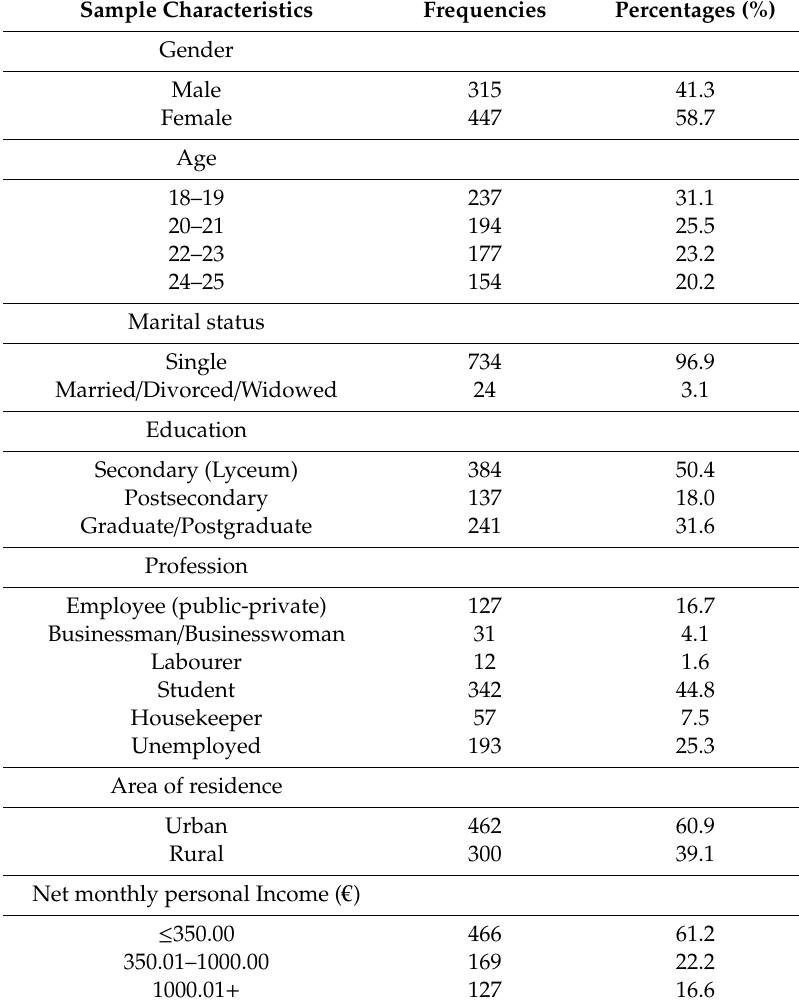
Table 1. Participants’ profile.